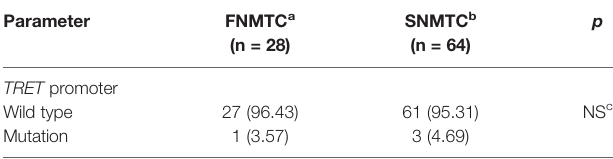
TABLE 6 | TRET promoter mutations in FNMTC and SNMTC, n